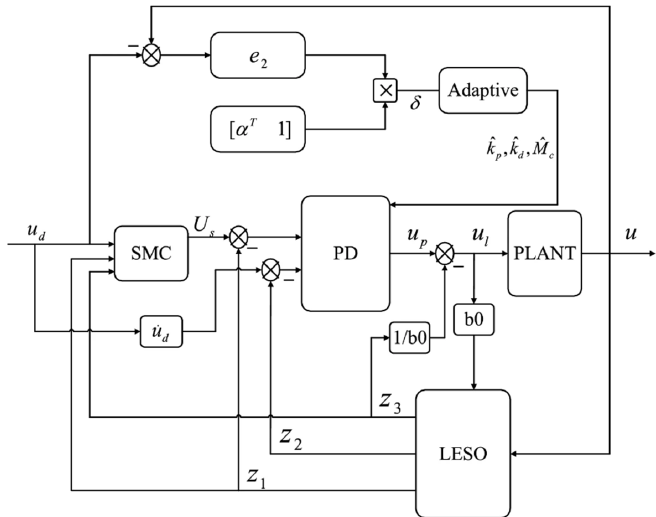
Figure 15. Structure diagram of a mass adaptive control method.